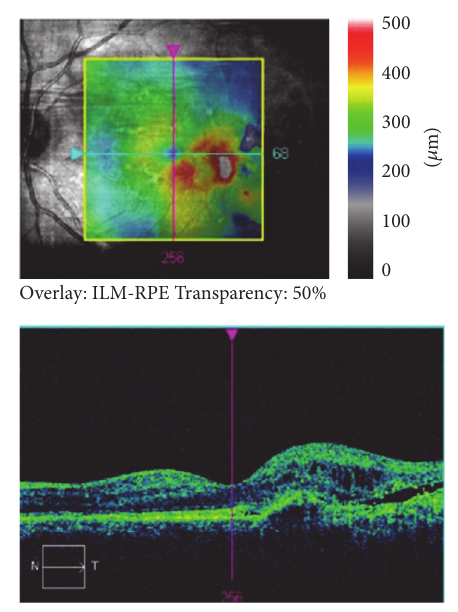
Figure 3: OCT scan of the left macular area of the patient at